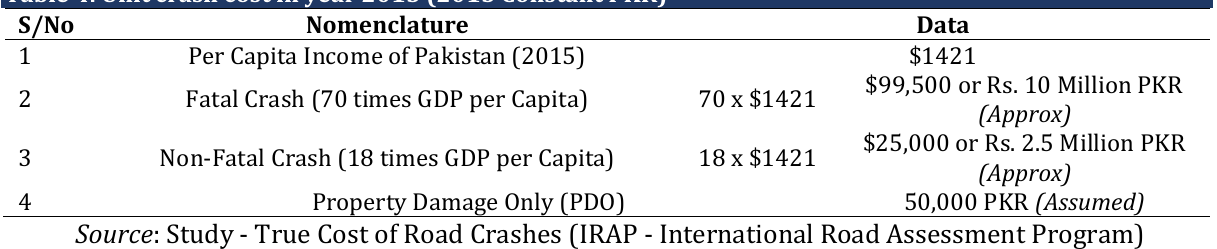
Table 5. Number of Crashes Occurred in each Method Work Zone